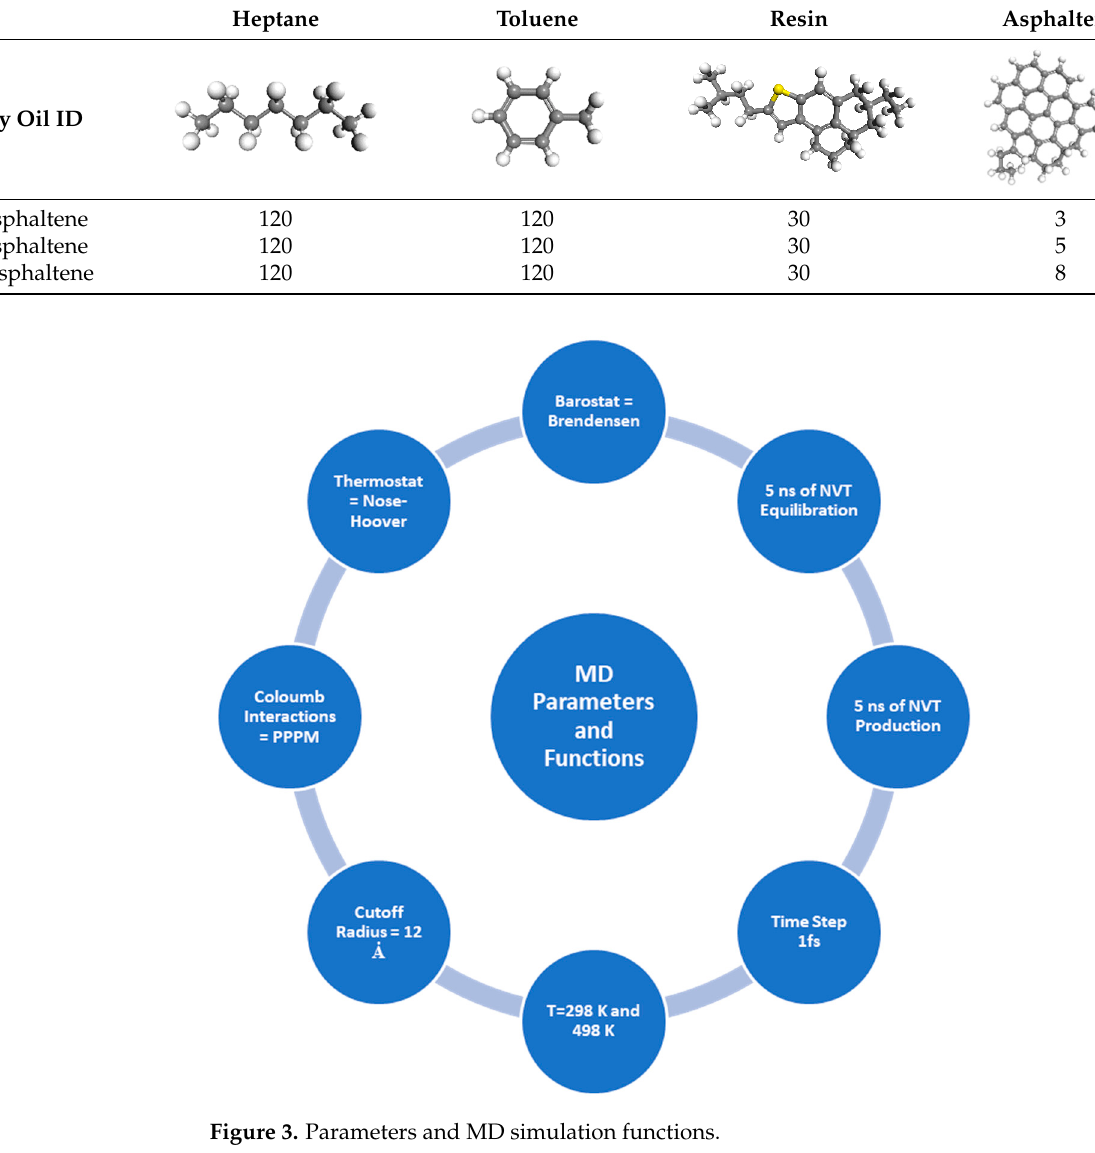
Table 1. Composition of the heavy oil droplets for each system.